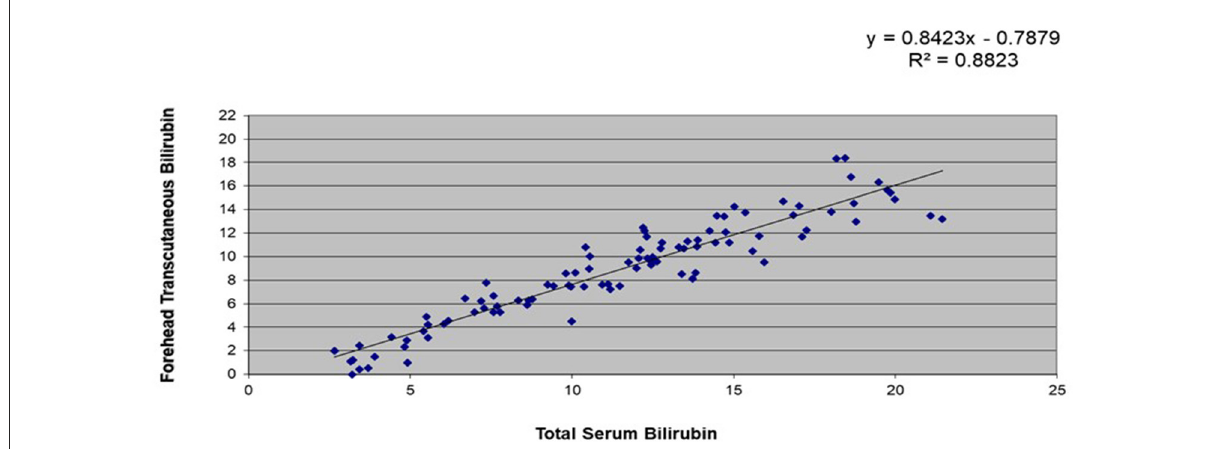
FIGURE1 Correlation between total serum bilirubin (TsB) and forehead transcutaneous bilirubin (TcB) levels among stable, full-term Filipino infants ( n = 106).